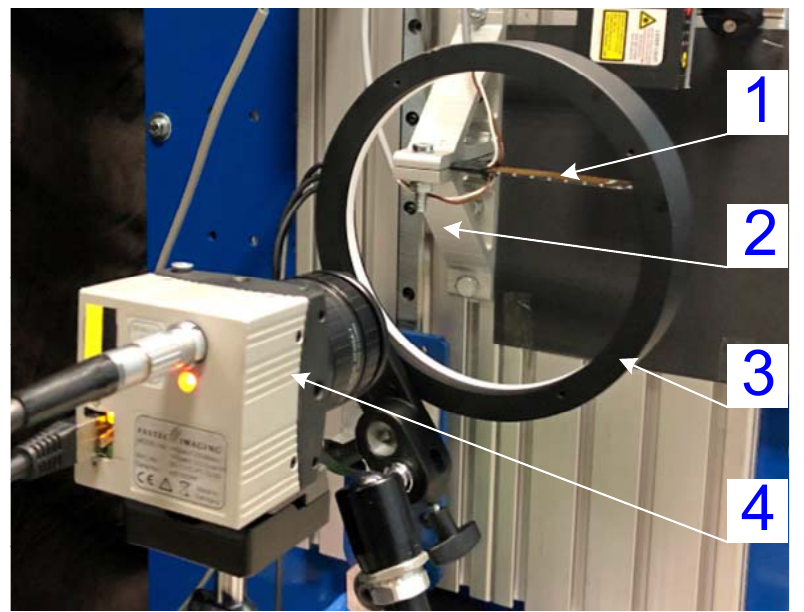
Figure 5. View of main parts of laboratory stand: 1—piezoelectric actuator, 2—clamping assembly, 3—diode illuminator, 4—camera.